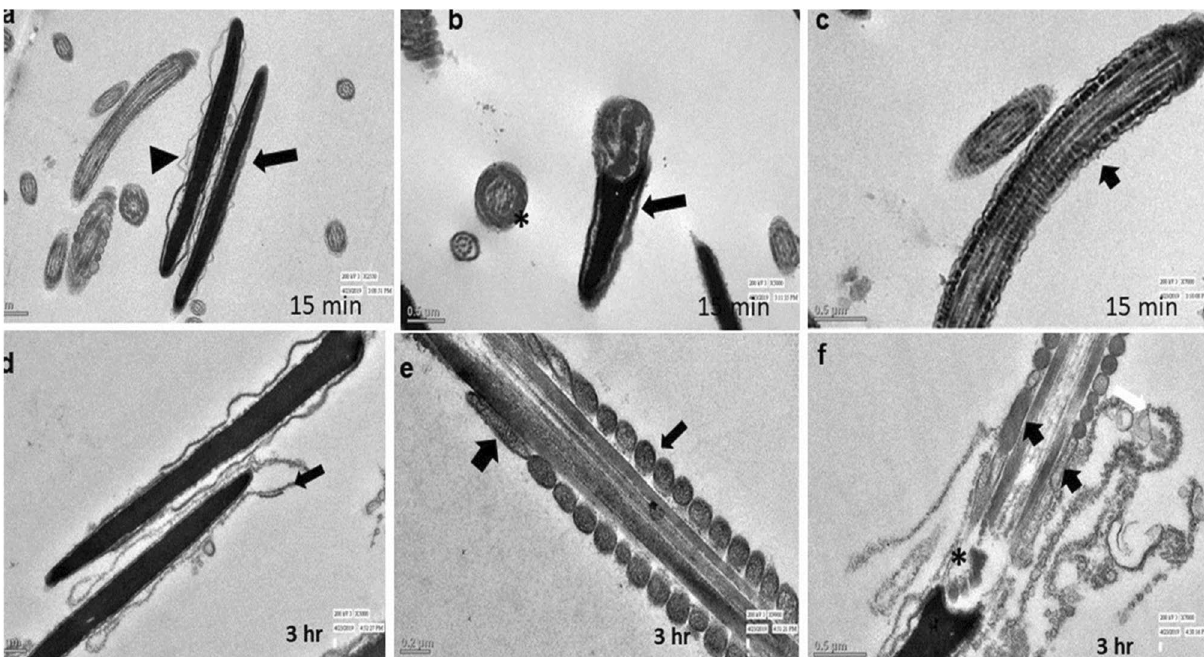
Figure 8. Transmission electron micrographs of goat spermatozoa exposed to 0.031 µg/ml HgCl 2 showing ultra-structural defects. ( a ) sperm head (arrow); damage membrane (triangle), ( b ) sperm head (arrow); axonemal components (star), ( c ) outer dense fibers (arrow), ( d ) reacted acrosome (arrow), ( e ) mitochondria (arrow); collapsed mitochondria (arrow), ( f ) disorganized outer dense fiber(star); collapsed mitochondria (arrow) after 15 min and 3